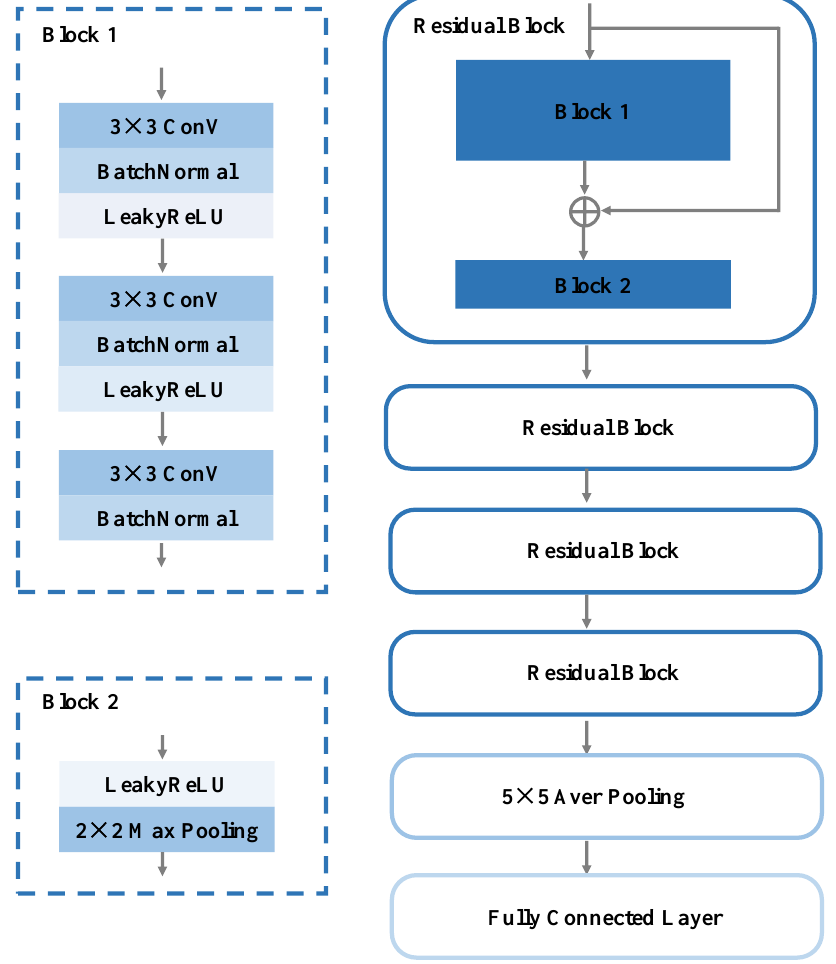
Figure 4. Schematic diagram of